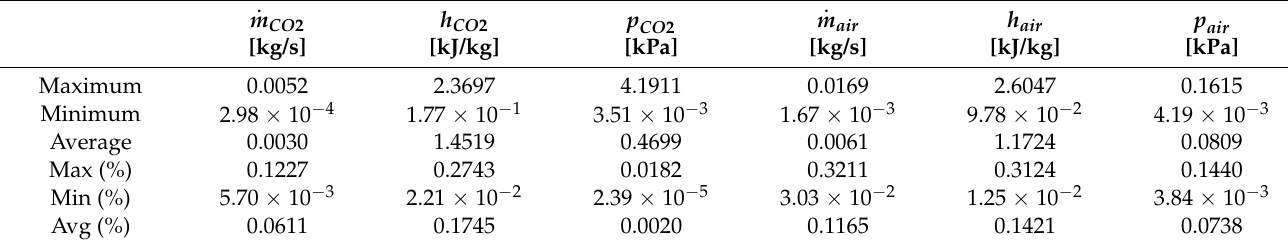
Table 6. Performance (absolute and relative errors) per output parameter for the PINN model of the heat exchanger network that used only Adam for optimization.